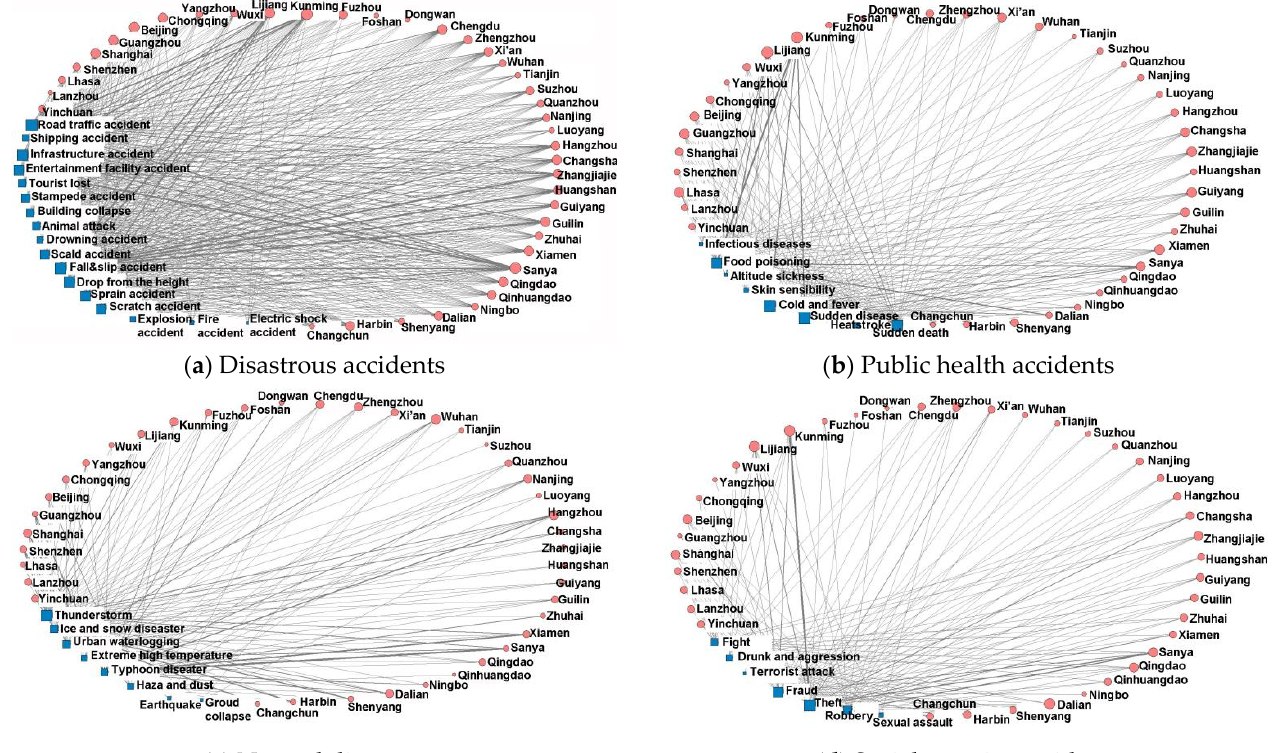
Figure 5. Two-mode structure network between subtype and cities.